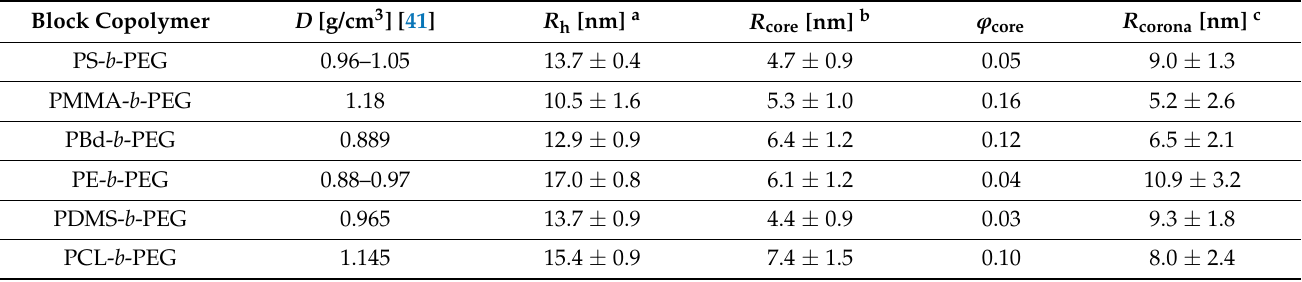
Table 6. Structural parameters of block copolymers